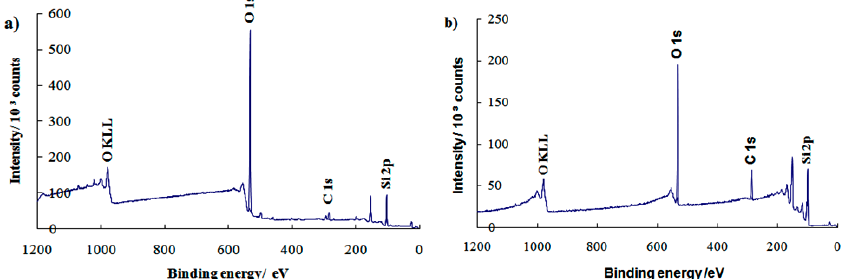
Figure 4. Wide scan X-ray photoelectron spectroscopy (XPS) spectra for ( a ) clean substrate and ( b ) PEG silane monolayer.